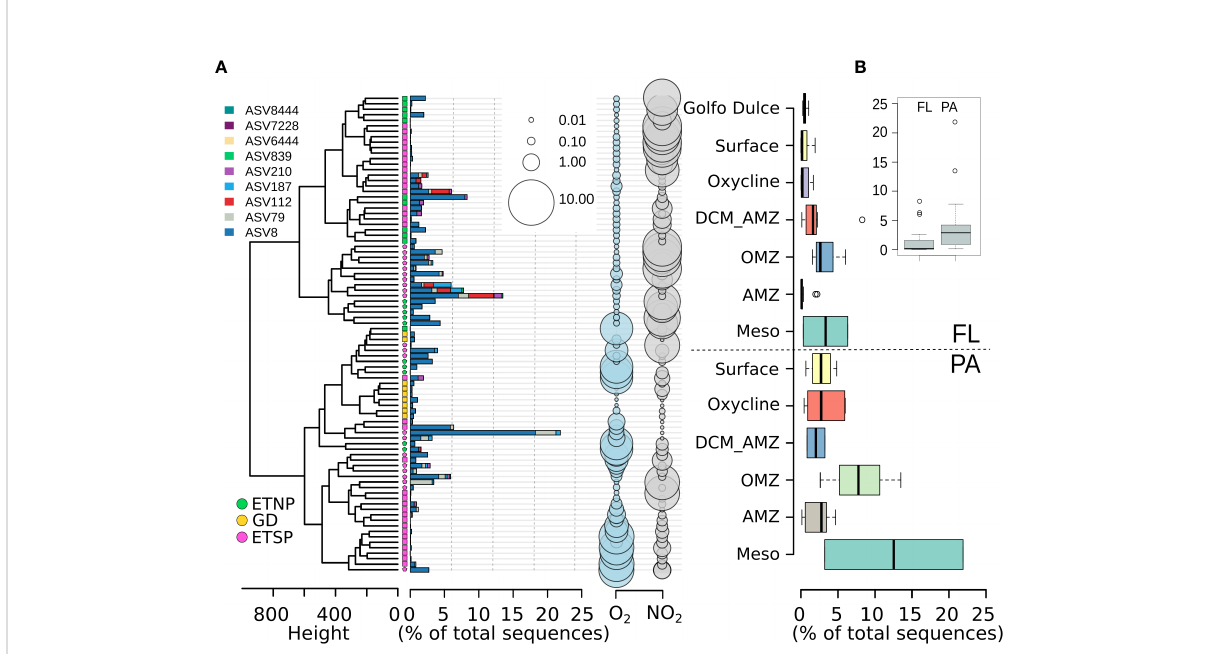
FIGURE 2 Alteromonas -related ASV abundances over the redox gradient of OMZ waters of the Paci fi c Ocean. (A) Alteromonas ASVs per sample as a percentage of the total reads in each sample. The color code corresponds to the different geographic locations. Samples from the free-living (FL) fraction are marked with squares. Particle-attached (PA) samples are marked with circles. Oxygen concentrations are presented in mL L -1 , and nitrite concentrations are presented in µM. (B) Barplot corresponds to the percentage of reads classi fi ed as Alteromonas relative to the total number of reads in each sample. ETNP, Eastern Tropical North Paci fi c; GD, Golfo Dulce; ETSP, Eastern Tropical South Paci fi c; O2, Oxygen; NO2, Nitrite; SFM, Secondary Fluorescence Maximum; Meso,